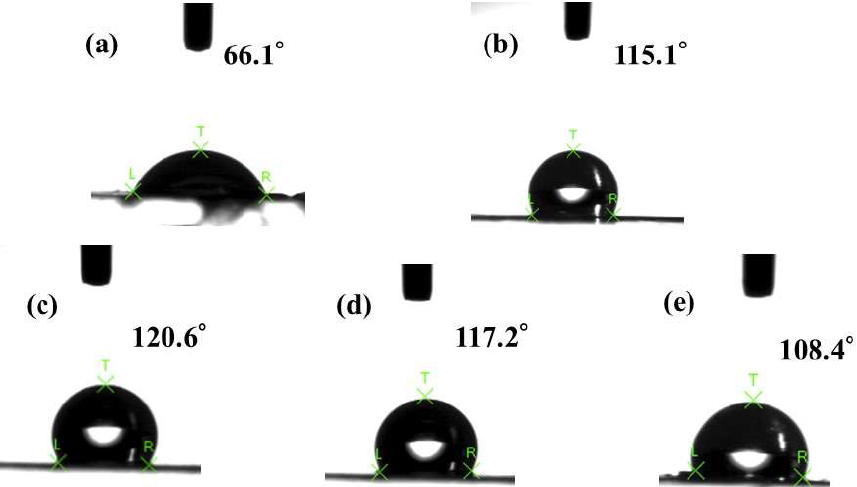
Figure 5. Water contact angle measurements on (( a ), entry 1) amylose-grafted PGA film and (( b – e ), entries 2–5) P2D-amylose-grafted PGA films.